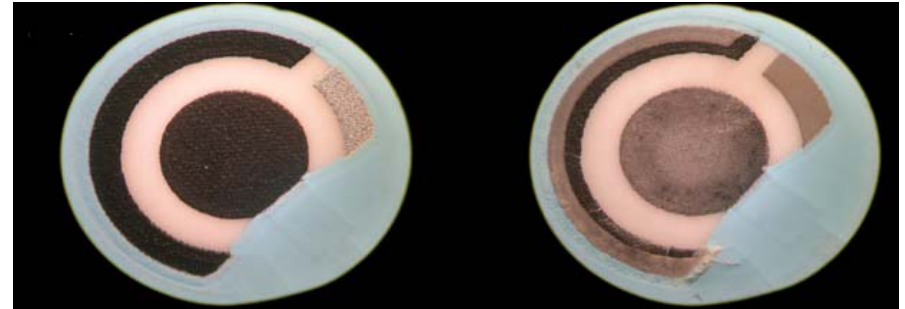
Figure 6. Optical microscopy pictures of the surface of the screen-printed electrode before ( left ) and after ( right ) performing 200 stripping voltammetric analyses. Experimental conditions as in Figure 4.